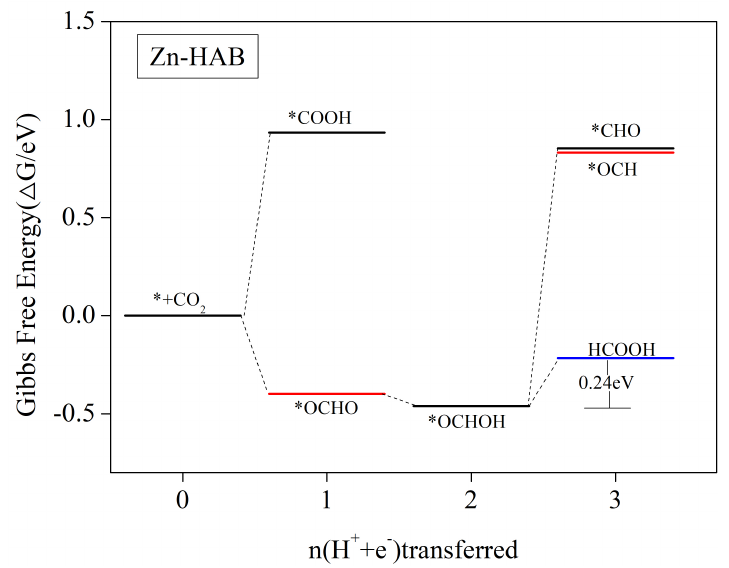
Figure 5. At zero potential, Gibbs free energy profiles for the CO 2 RR along the most favorable routes for Zn-HAB. A CO 2 molecule in the gas phase with a clean catalytic surface is assigned a free energy of